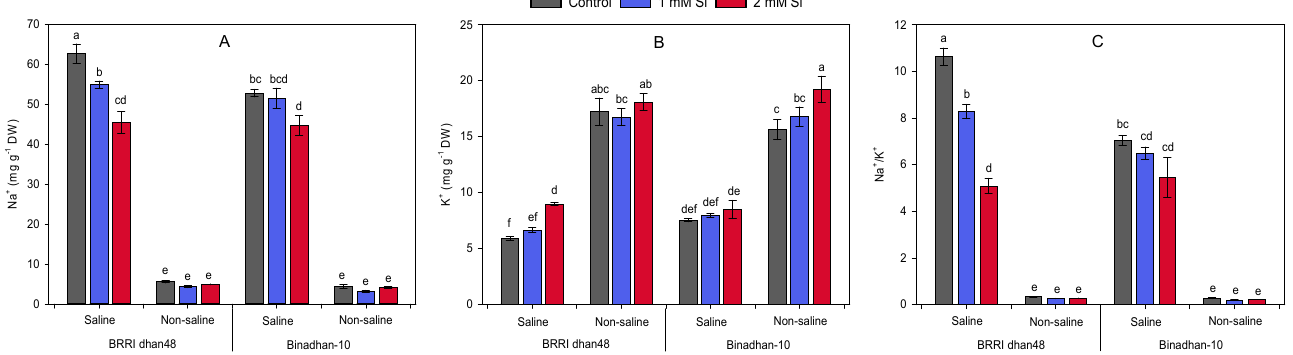
Figure 4. Effect of Si pre-treatment (1 and 2 mM silicic acid) on ( A ) Na + , ( B ) K + content and ( C ) Na + /K + ratio in the shoots of two contrasting rice cultivars subjected to salt stress (10 dSm − 1 ). Different letters above the bars indicate significant differences among the treatments following Tukey’s HSD test.